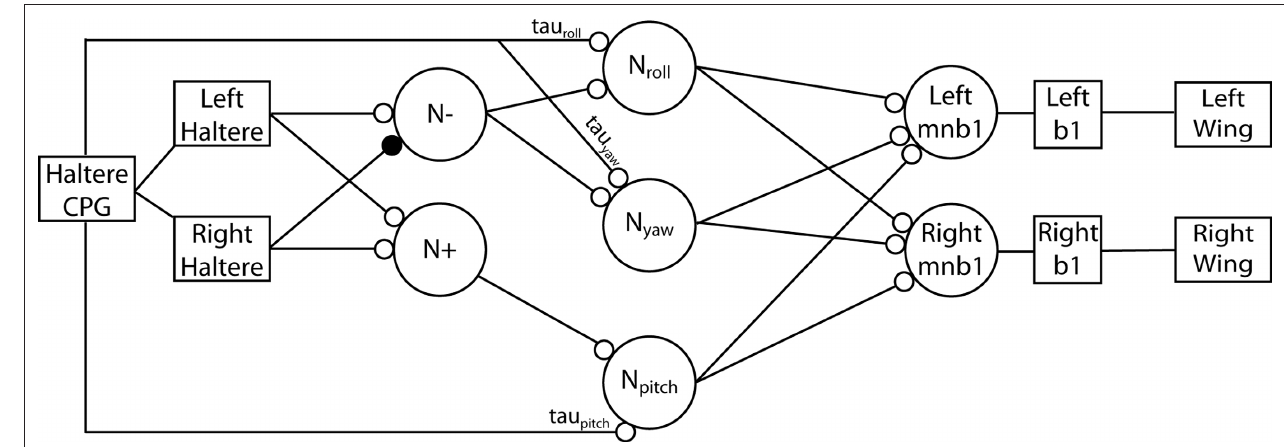
Figure 3 | Neural circuit for angular velocity computation. Squares – anatomical structures; circles – neurons; smaller open circles – excitatory connections; smaller filled circle – inhibitory connection. The haltere CPG drives the left and right halteres which sense lateral forces. These force signals are summated at the neuron labeled N + and subtracted at the neuron labeled N − . The signals from these neurons are then transmitted to three intermediate